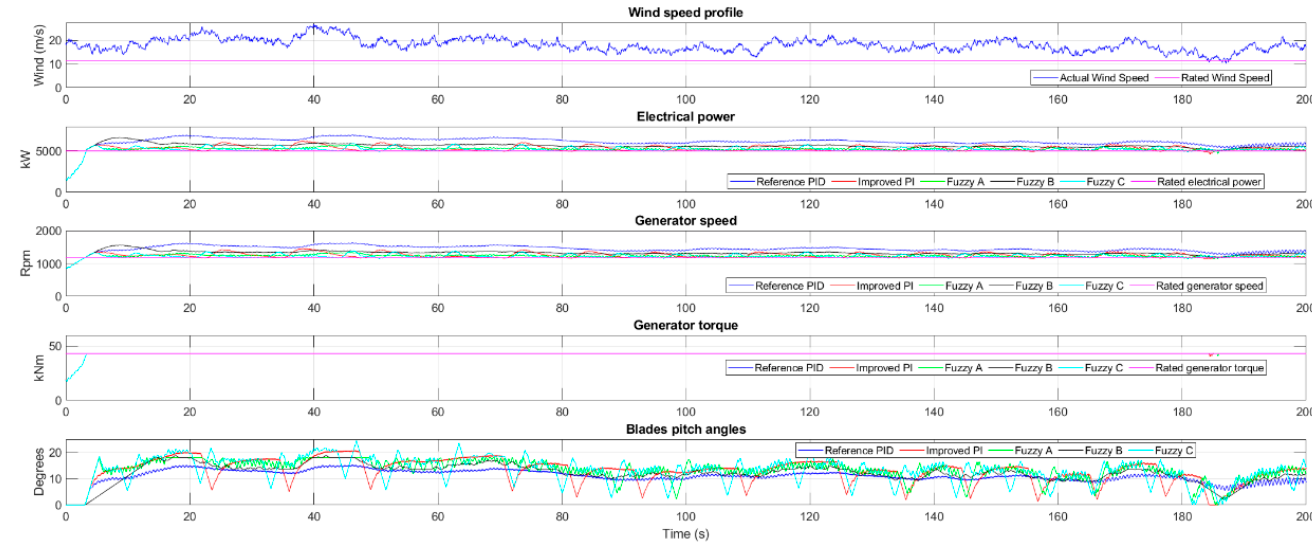
Figure 15. Comparison of the evaluated controllers for a wind profile of 15 m/s.